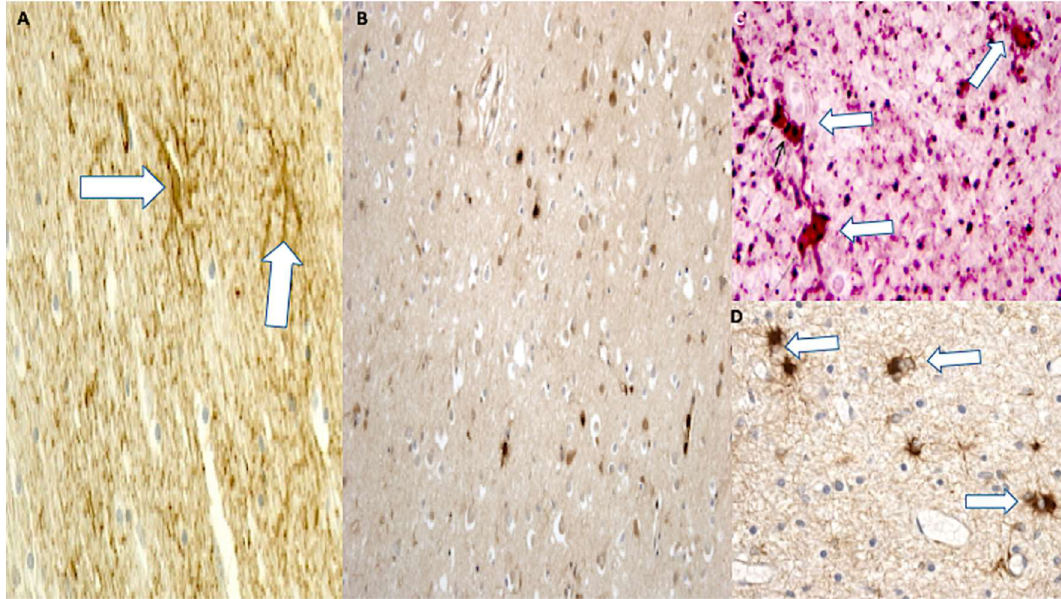
Figure 9. ( A ) CD68 immunopositivity (white arrows) increased significantly at early time points of survival (one and three day survival) until 30 days (magnification 150 × ). ( B ) Group 6: diffuse brown positivity (magnification 100 × ). ( C ) IBA-1 reactions showing dendritic morphology (white arrows) (magnification 150 × ). ( D ) An increase in the number of IBA-1 immunopositive cells (white arrows) was progressively observed at high magnification (200 × ) (group